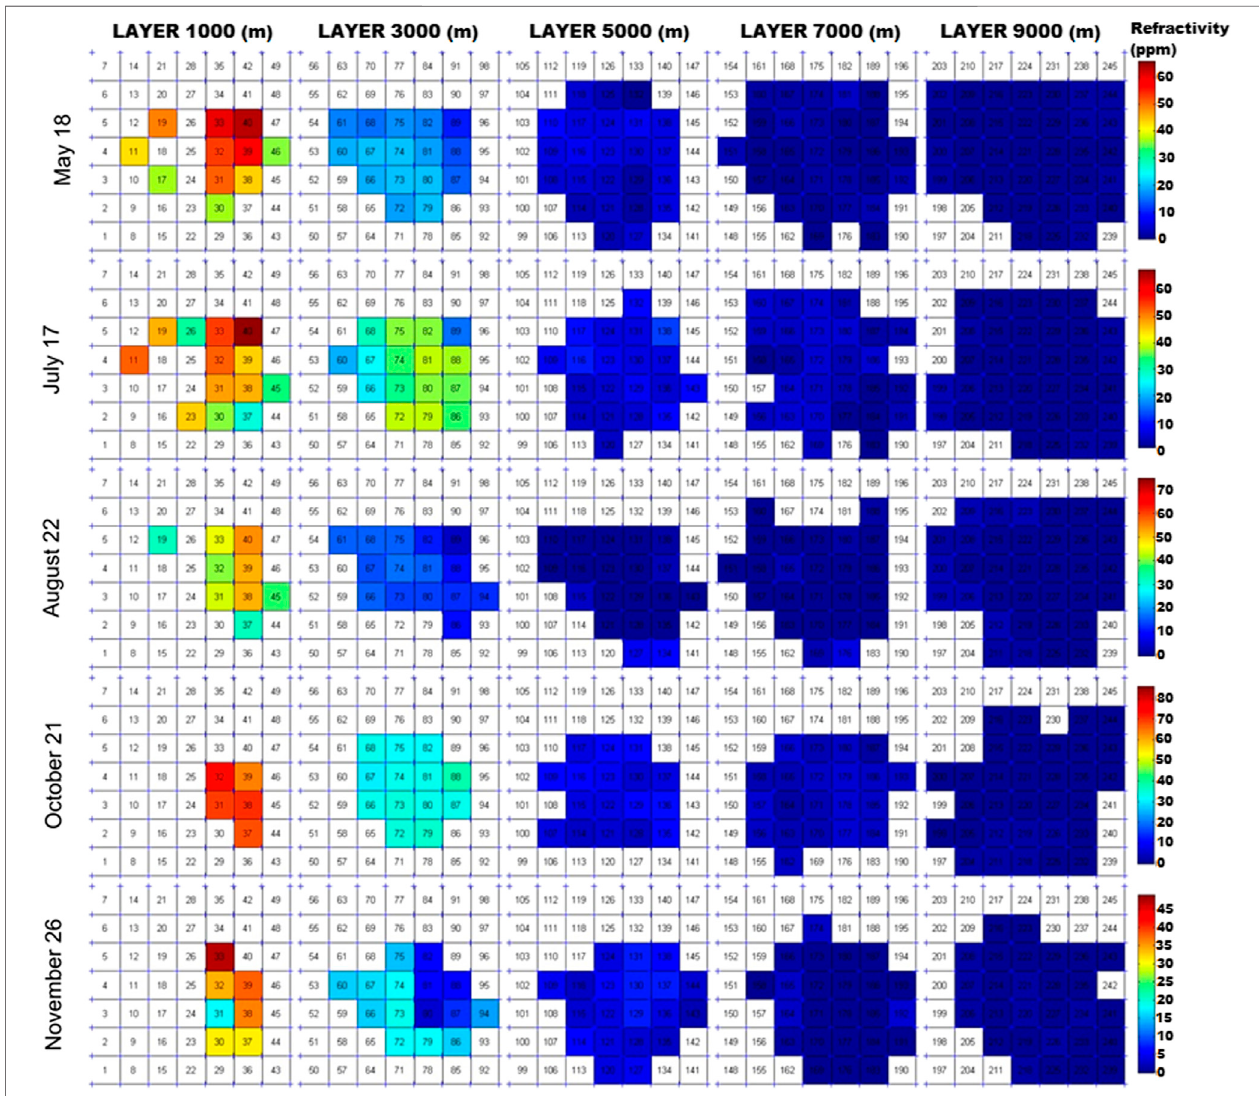
FIGURE7| Wetrefractivitytomographyoftheselected actual cases. Each testcase hasadifferent colorscaleinordertoappreciate thevariationsoftheindividual test case.